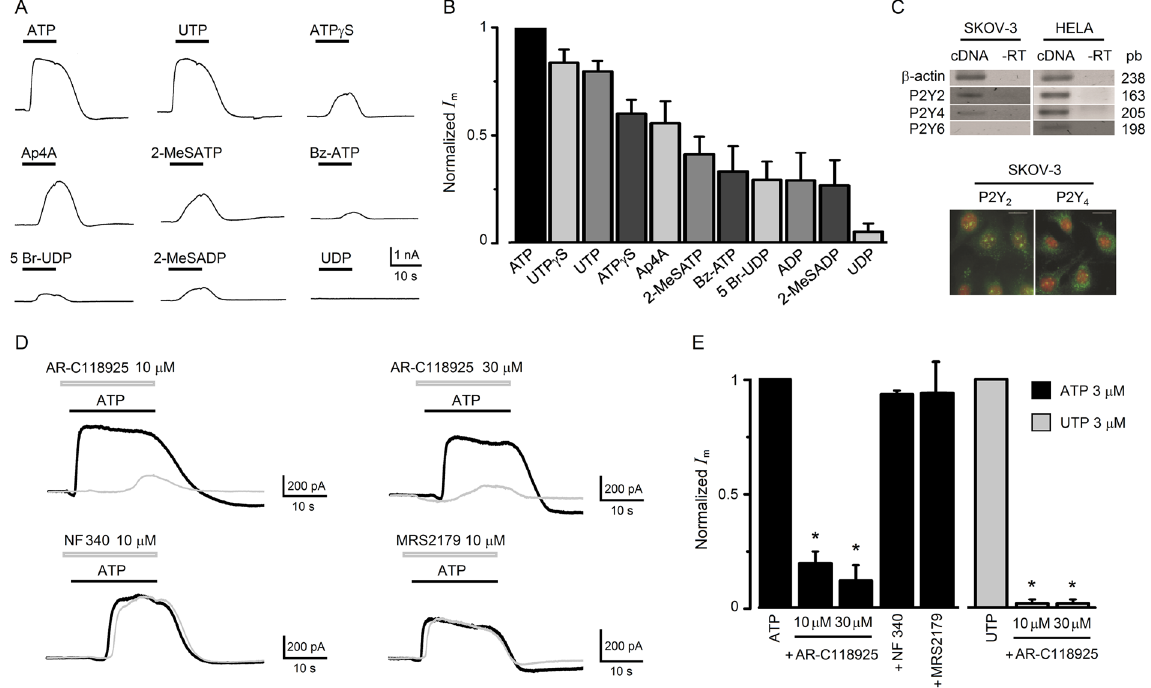
Figure 3. Purinergic pharmacology and expression of the receptor involved in the electrical response in SKOV-3 cells. ( A ) A battery of different agonists (all applied at 3 µ M) for purinergic receptors was tested in cells held at − 40 mV, and the peak current amplitude for each agonist was normalized against that obtained by applying ATP. This resulted in the potency sequence illustrated in graph ( B ) where data obtained in 50 cells are summarized. ( C ) The upper panel shows the PCR analysis for P2Y receptors sensitive to ATP/UTP; P2Y 2 , P2Y 4 and P2Y 6 receptor subtypes. In SKOV-3 cells, bands with the expected size were obtained for P2Y 2 and P2Y 4 subtypes but not for P2Y 6 (mRNA from HELA cells was used as positive control, and -RT indicates the corresponding reaction control without reverse transcriptase). The images show immunorecognition for P2Y 2 or P2Y 4 receptor proteins in SKOV-3 cells observed by epifluorescence (P2Y receptor in green and nuclei in red labeled with propidium iodide). Scale bar 10 µ m. ( D ) Traces illustrate the effect of AR-C118925,